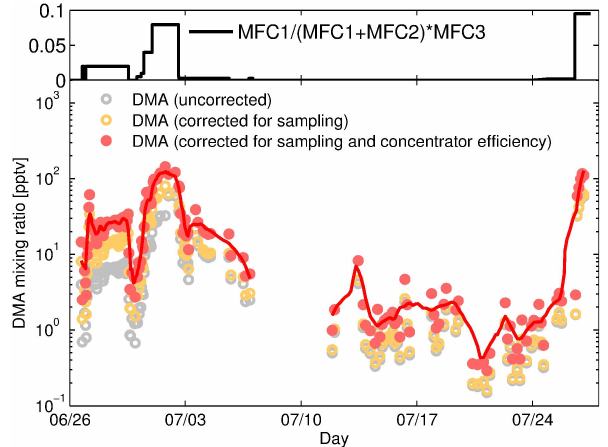
Fig. 5. Overview of ammonia (NH 3 ) mixing ratios (in pptv): un- corrected (grey), corrected only for concentrator column efficiency (filled light blue), and corrected for background levels as well as concentrator columns efficiency (filled dark blue). The continuous line is a smoothing function through the final data.